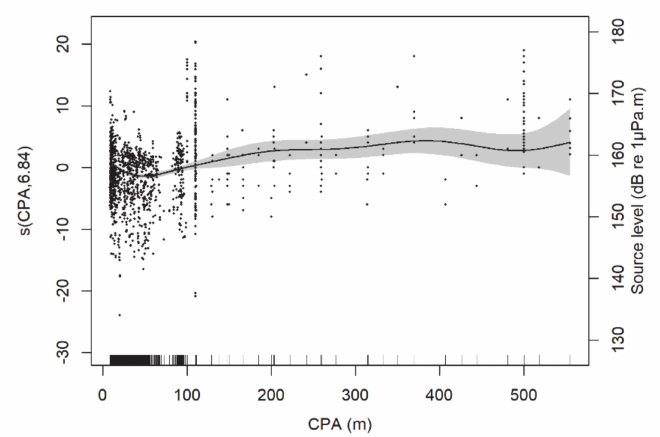
Figure 4. Estimated smoothing function (solid line) with 95% confidence intervals (shaded area) for CPA, illustrating the relationship between CPA and source level (SL). The recorded data were added as points with the secondary y-axis (right). The secondary y-axis also displays the smoother with the estimated intercept added (presenting the fitted